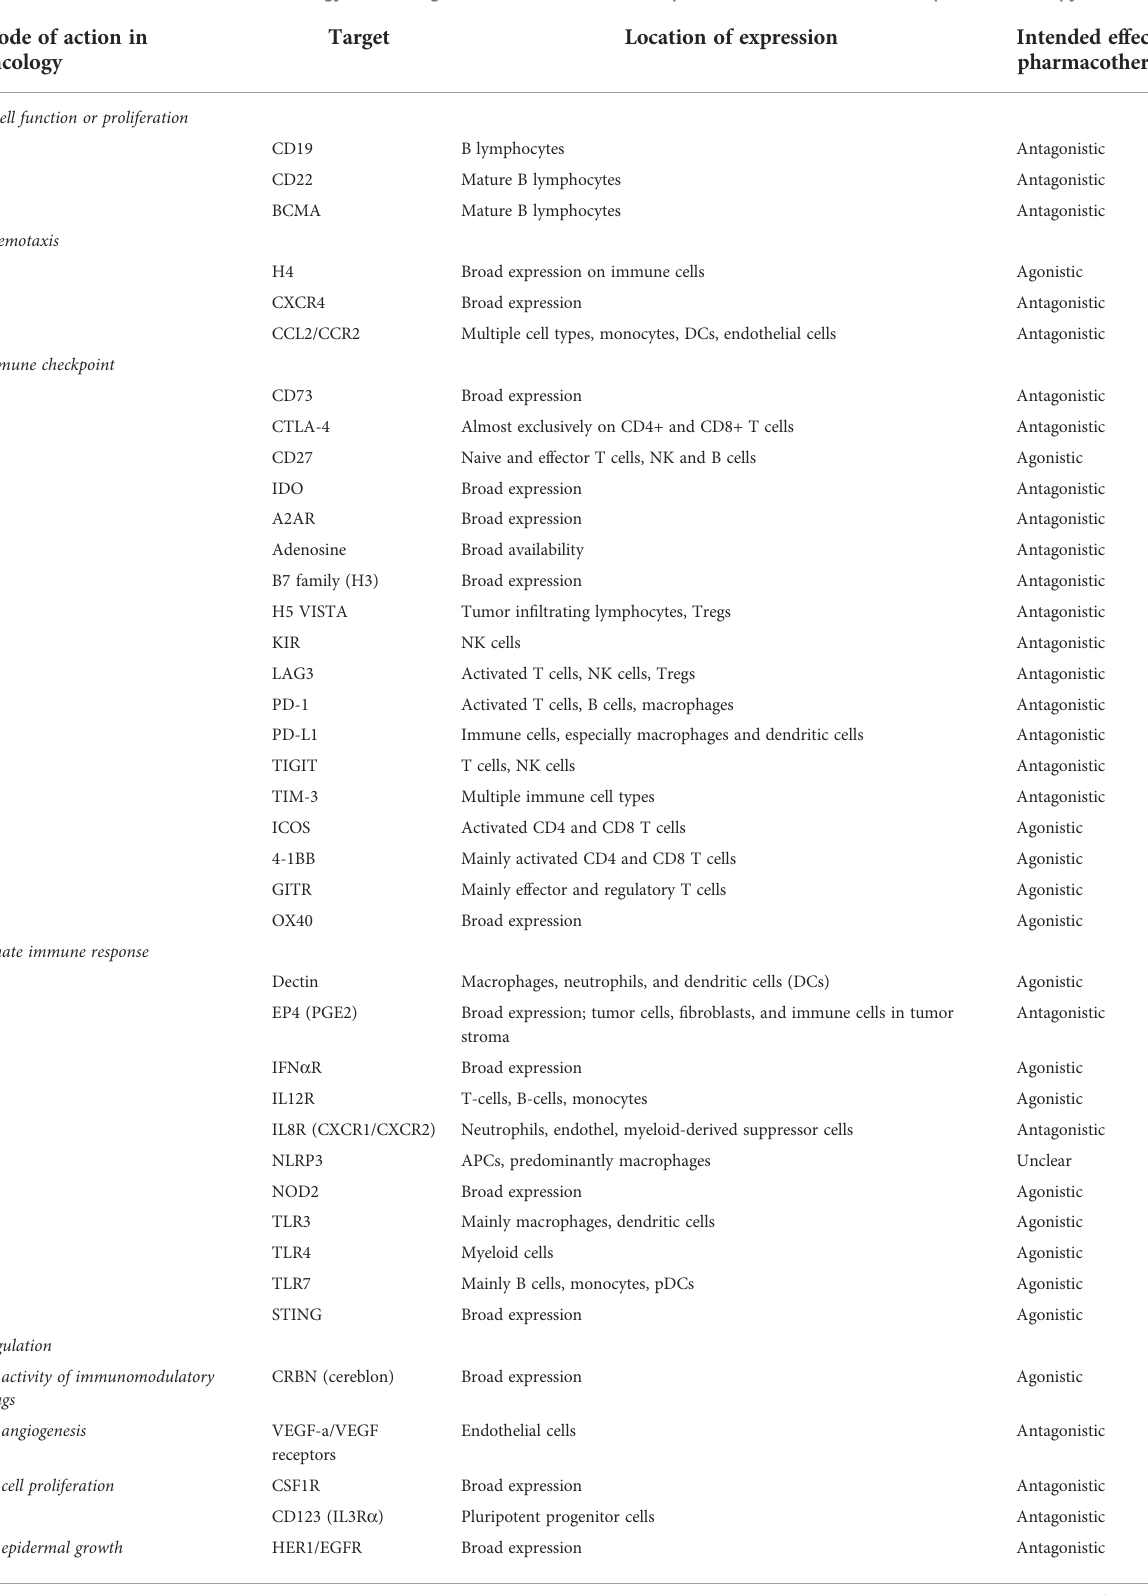
TABLE 1 Overview of the relevant oncology search targets, with their location of expression and intended effect of